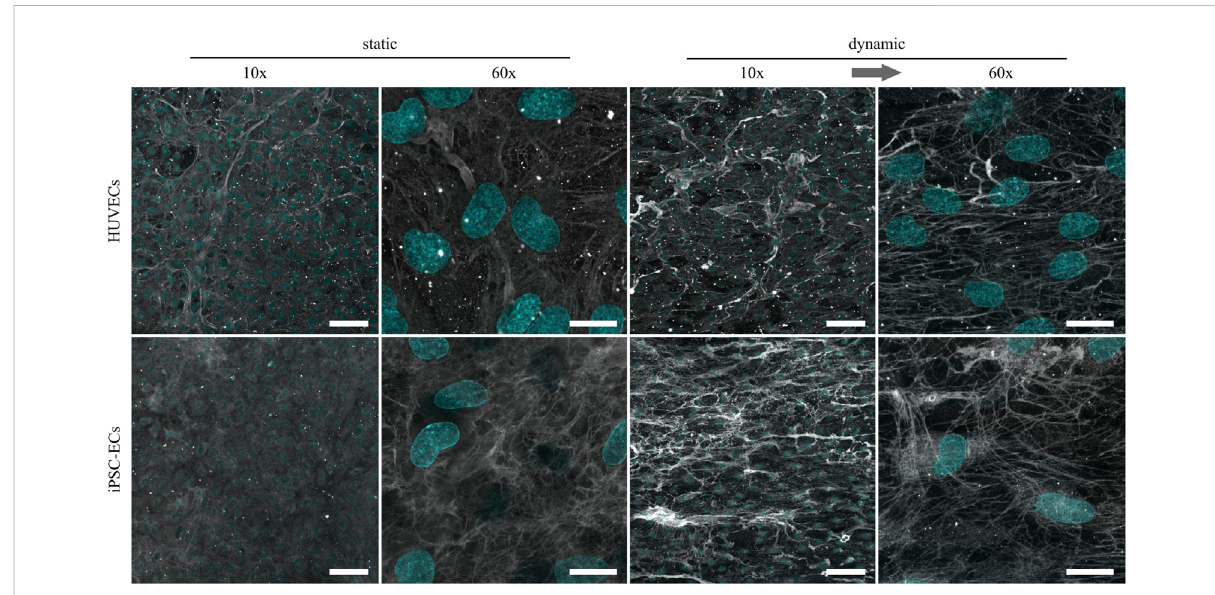
FIGURE 5 Representative confocal immuno fl uorescence images of a heparan sulfate staining (grey) of HUVECs and iPSC-ECs after 96 h of static and dynamic culture. Nuclei were counterstained with Hoechst 33342 (cyan). (Arrow indicates fl ow direction. Scale bars: 10× 100 µm, 60× 20